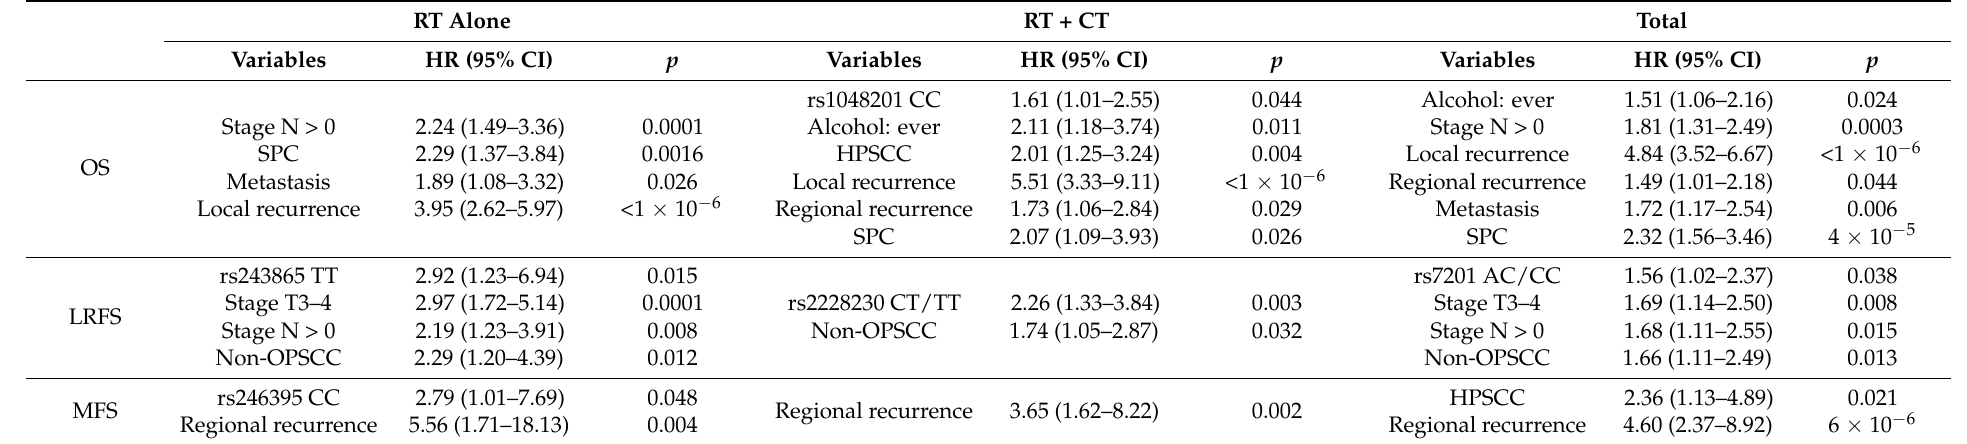
Table 2. Independent risk factors for OS, LRFS, and MFS—the final